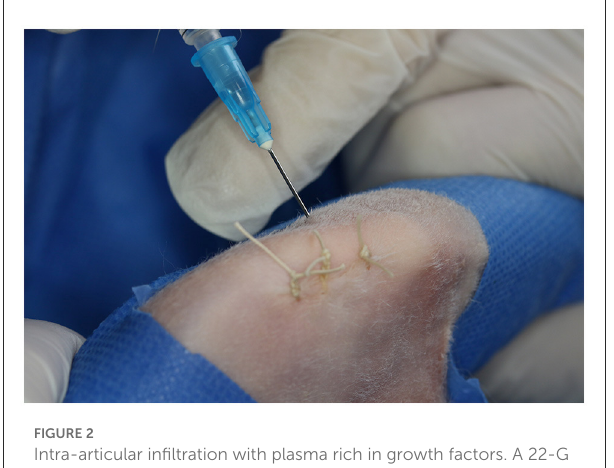
FIGURE2 Intra-articular infiltration with plasma rich in growth factors. A 22-G needle was inserted laterally to the patellar tendon and 0.25mL of plasma rich in growth factors were IA injected.